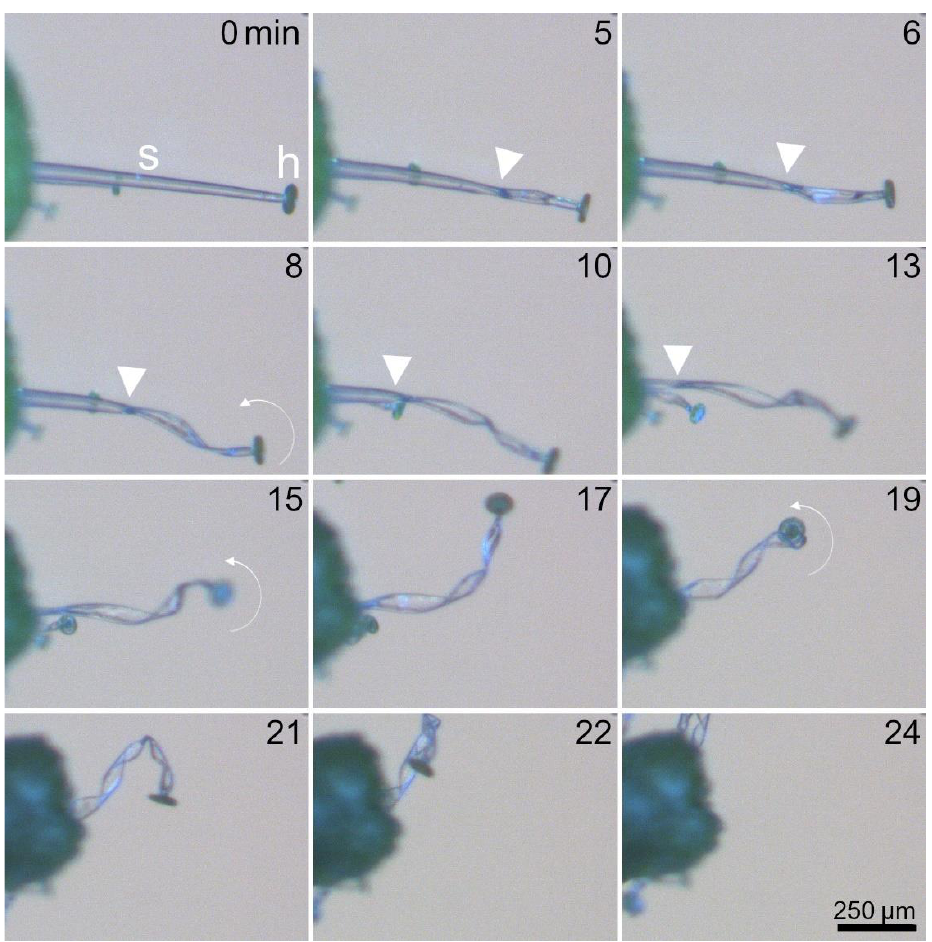
Figure 7. Kinematics of a stalked gland drying in air. The thick white arrows indicate the boundary region between the still cylindrical area and the already flattened area of the stalk cell (s), which proceeds towards the basal region of the stalk cell over the course of time. The head (h) of the stalked gland is indicated. Fine white arrows indicate twisting of the stalk cell and rotation of the head. Times [min] are indicated. The images are frames from Movie S9.